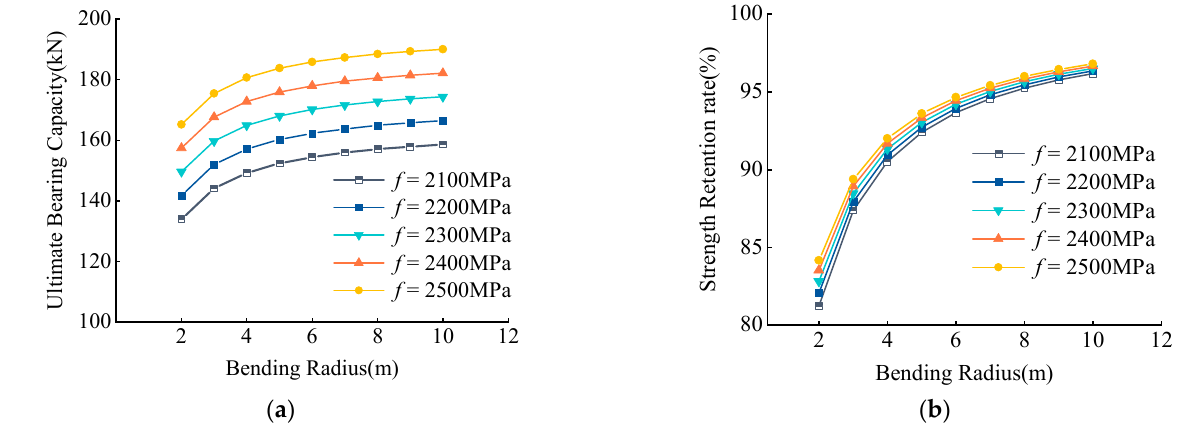
Figure 14. ( a ) Effects of f on UBC, ( b ) Effects of f on RSR. Effects of tensile strength f on UBC and RSR. Examination of the variation of the UBC and RSR of CFRP tendons with different elastic modulus with the bending radius showed that they increased with an increased bending radius (Figure 15). When the bending radius was constant, both the UBC and the RSR decreased with an increased elastic modulus, residual strength decreased by less than 6%, and the magnitude of decrease was small.